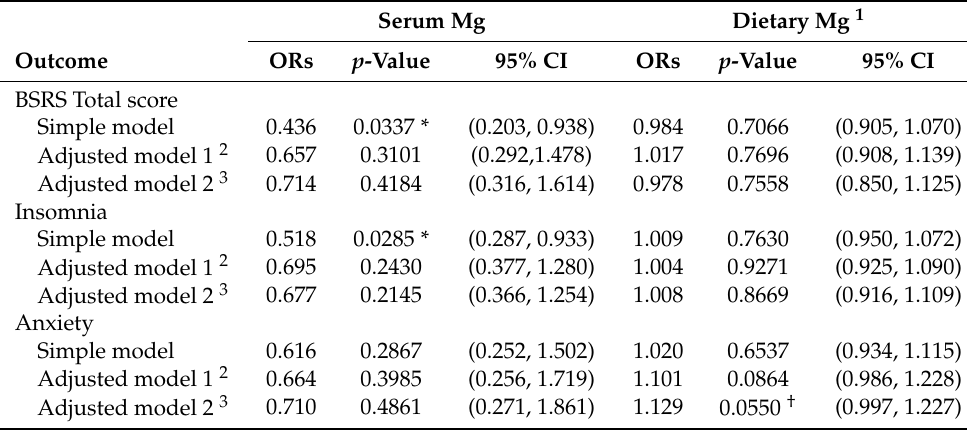
Table 3. Simple and multiple logistic regression analysis of BSRS-5 outcome measures versus predictor variables (dietary or serum